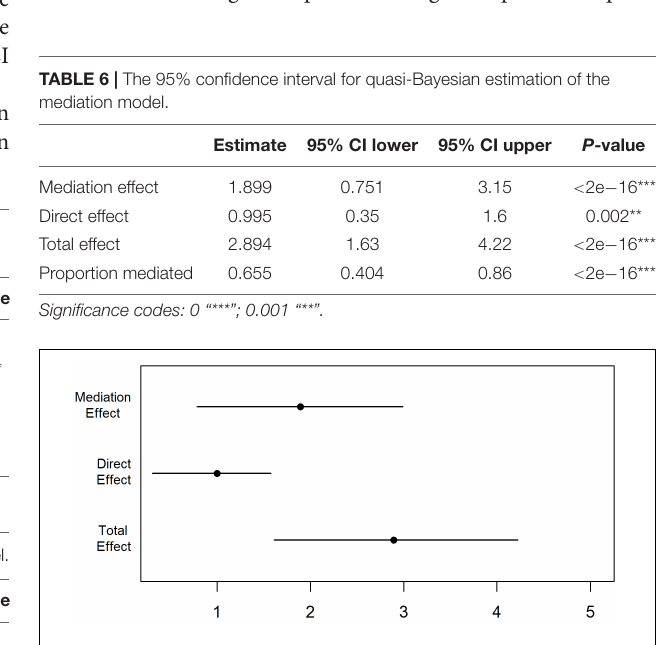
FIGURE 4 | The mediation effect. The indirect path between dose and Cog via qEEG shows a more robust and higher estimate than the direct effect. The black diamond symbol shows the point estimate, and the line shows the 95% quasi-Bayesian confidence intervals. The mediation effect explains 66% of the total effect. There is also a significant direct effect between doses and Cog , which is not explained by qEEG . A positive mediation and direct effect show that a higher dosage is associated with higher latent cognitive